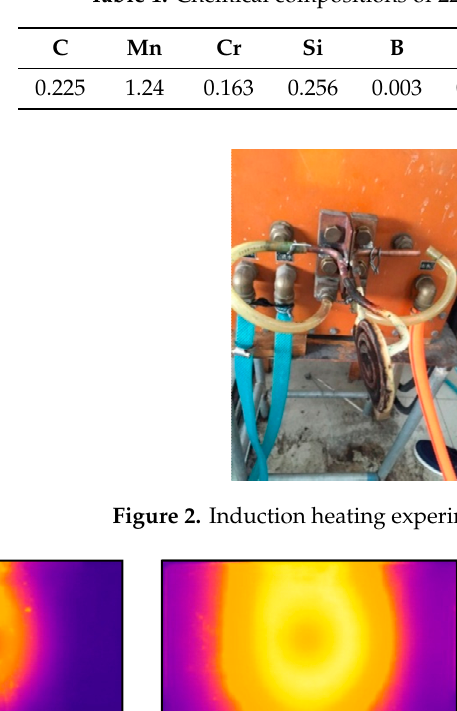
Figure 1. Strategic mechanism of selective heating and press hardening.